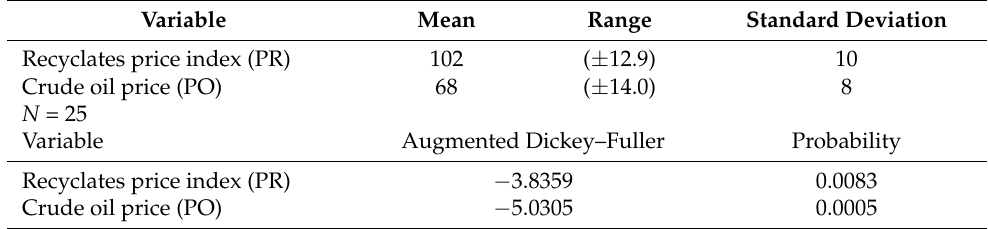
Table 2. Descriptive statistics and Unit Root results for crude oil and recyclates prices.